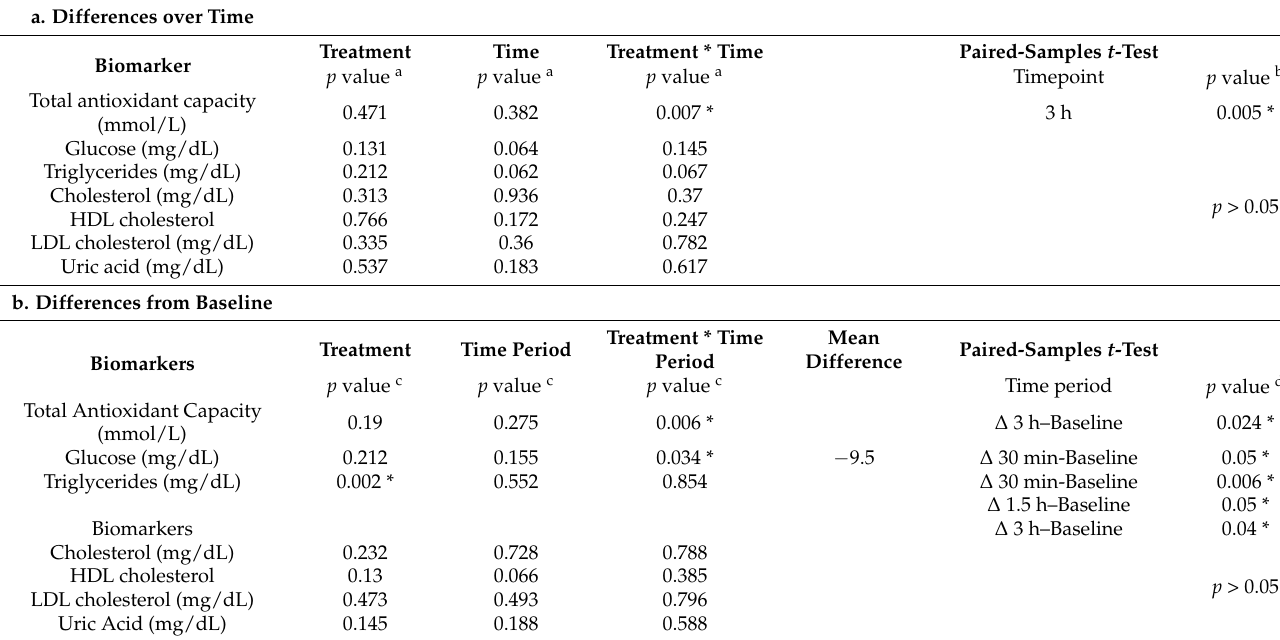
Table 6. Differences between Control and Functional treatments over time and for changes from baseline, referring on the tested